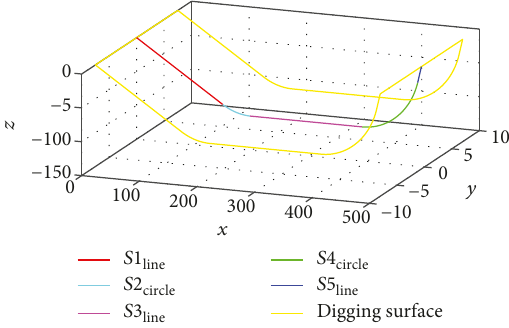
Figure 10: Movement trajectory calculation